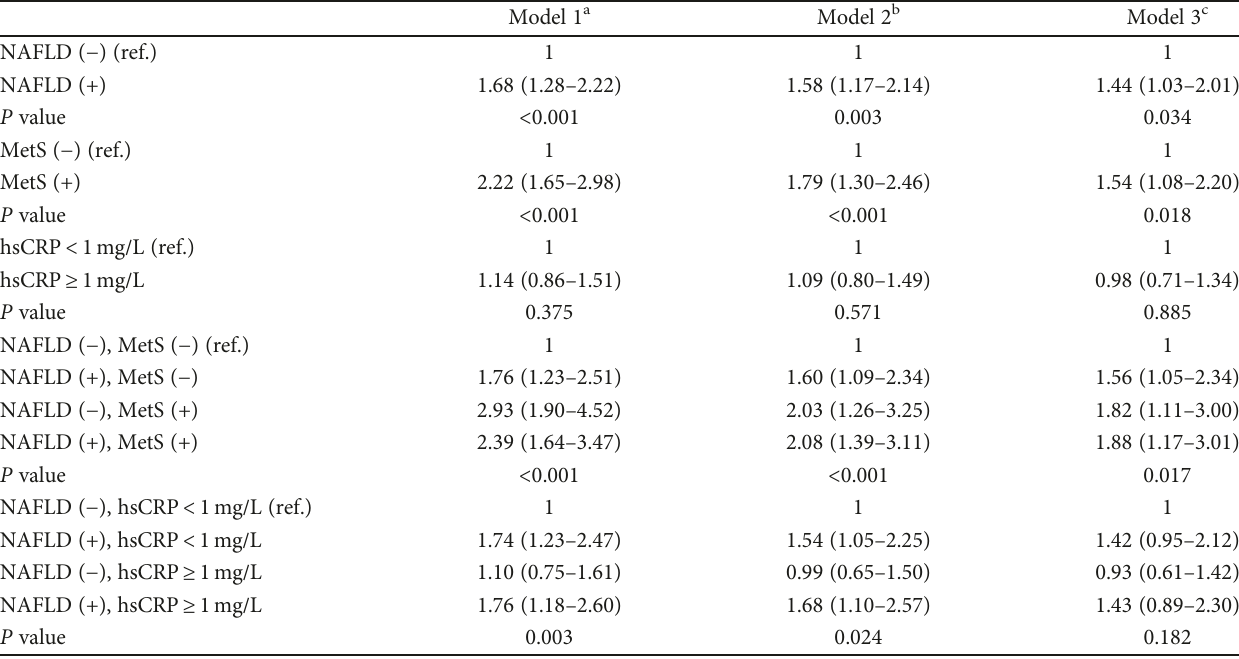
Table 3: Odds ratios and 95% con fi dence intervals of mild renal insu ffi ciency (eGFR ≥ 60 and < 90 mL/min/1.73 m 2 ) with respect to the presence of NAFLD, MetS, and high